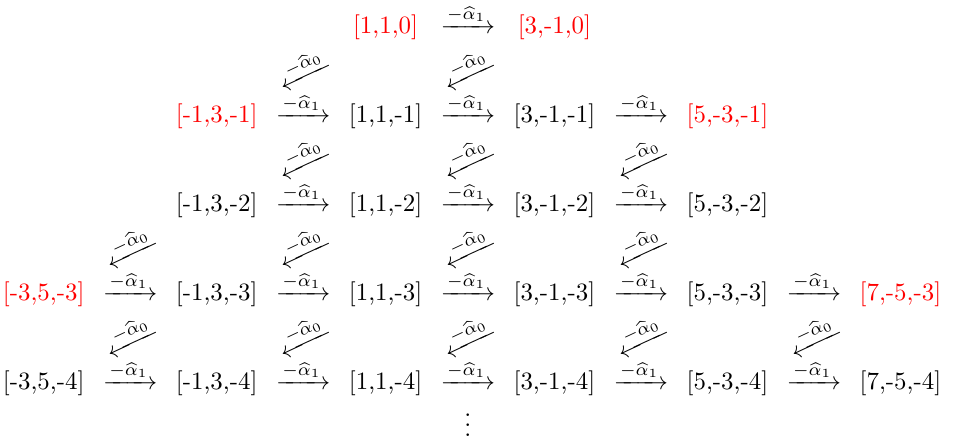
Table 6 . Weights of the a(cid:14)ne highest weight representation [1 ; 1].